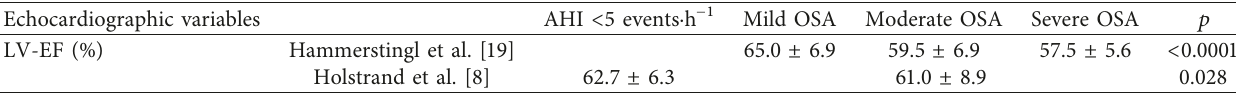
Table 3: Left ventricular ejection fraction and OSA